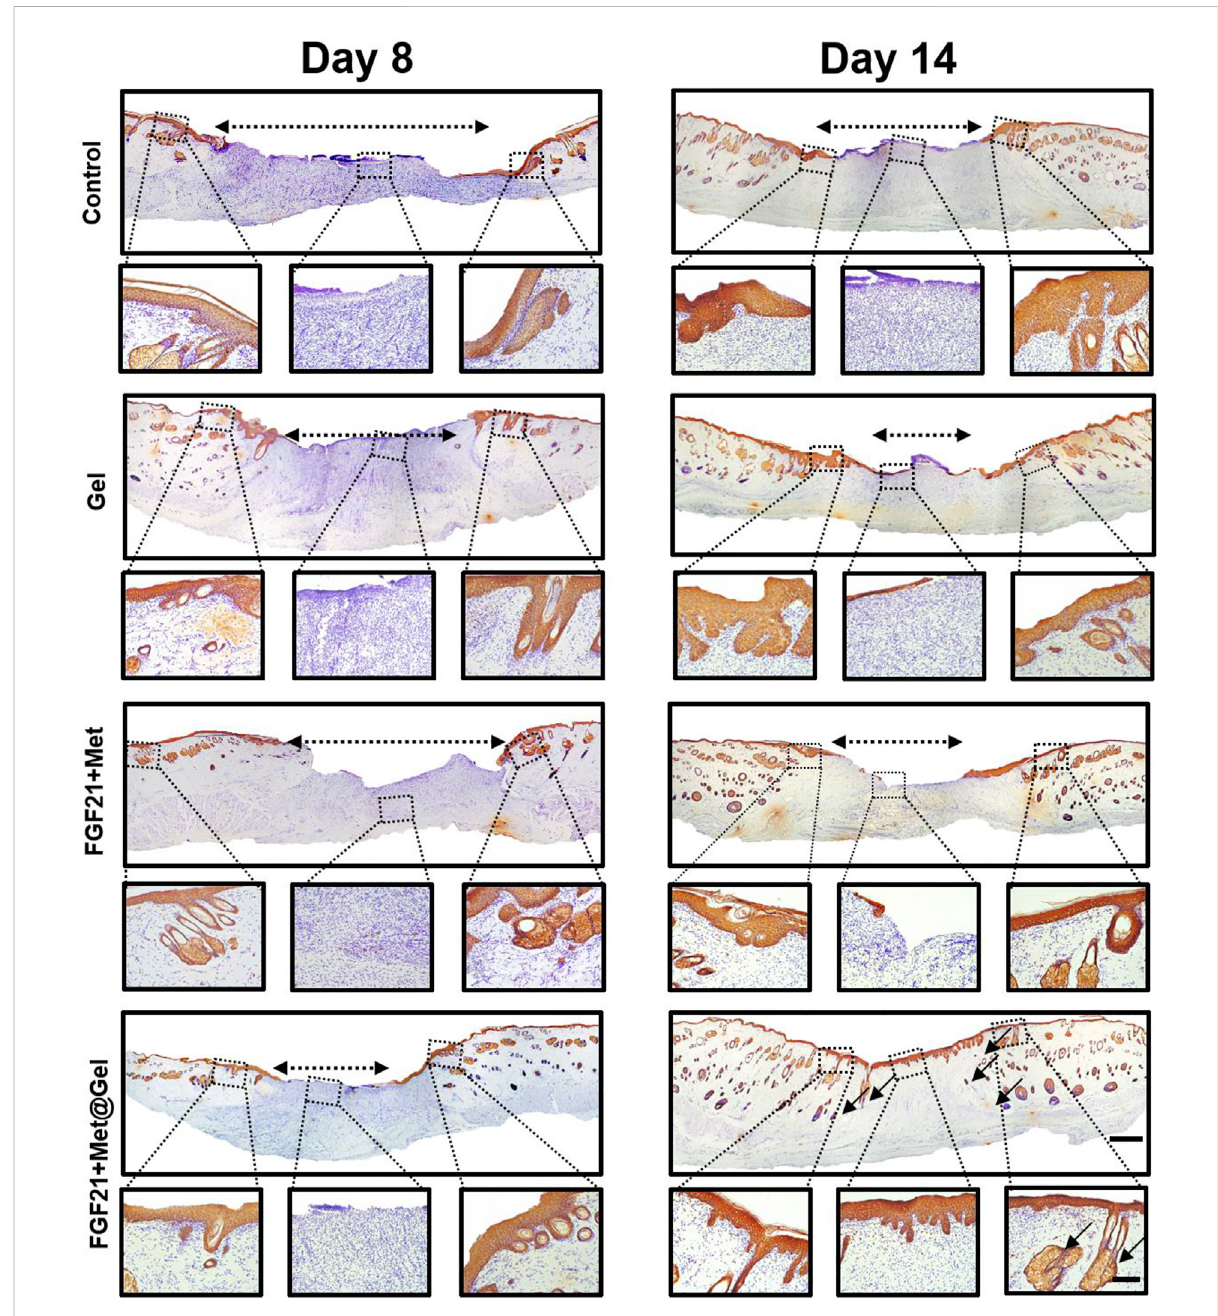
FIGURE 6 Representative images of immunohistochemical staining of skin tissues on days 8 and 14 (original scale bar = 1000 μ m). Dashed box presents the corresponding higher magni fi cation immunohistochemical staining of wound bed centers and edge (close-up scale bar = 250 μ m; dash lined with double arrows indicated re-epithelization gap, arrows indicated new hair